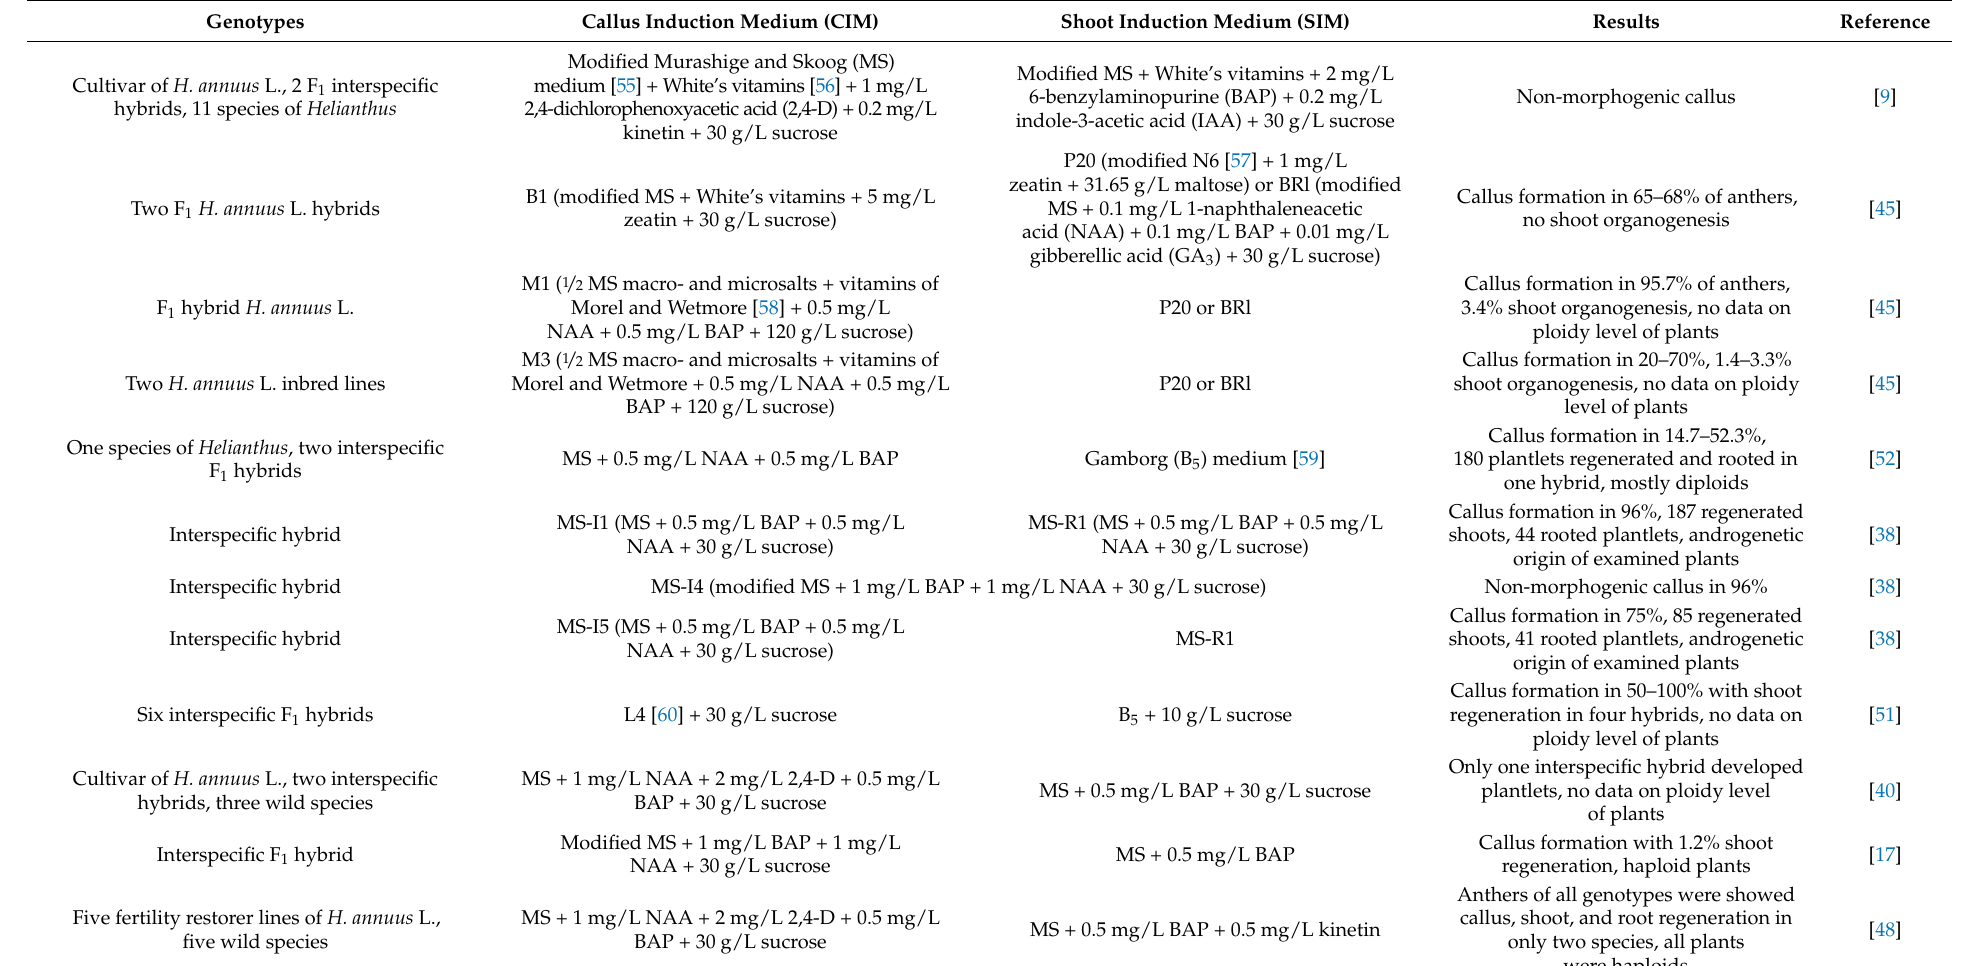
Table 1. Callus formation and shoot organogenesis in sunflower anther